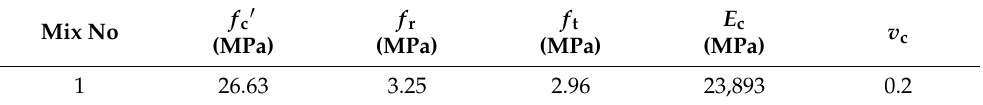
Table 2. Mechanical properties of the concrete. Adapted from Ref. [23].